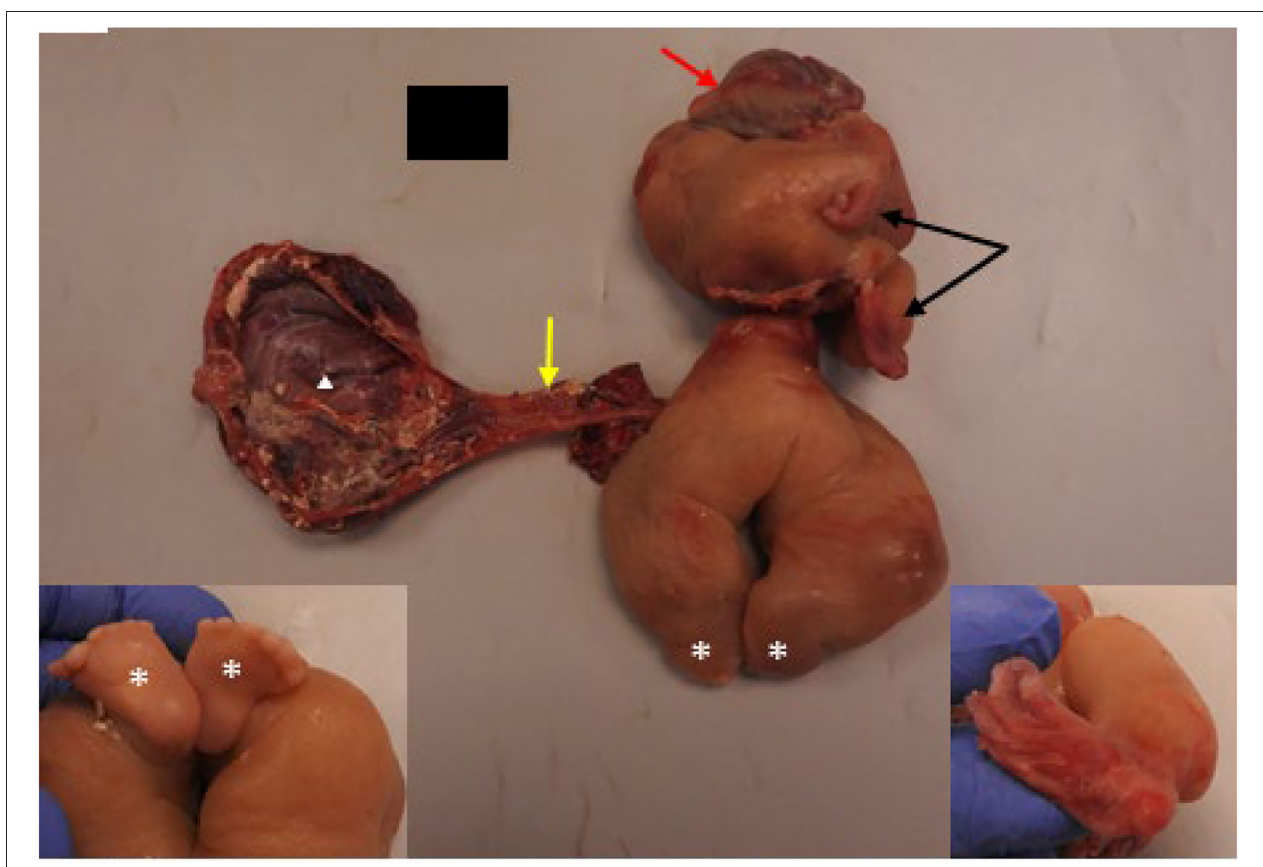
FIGURE 4 | Pathologic features of resected FIF with gross examination showed a malformed fetus with rudimentary upper (black arrows) and lower (white asterisks) extremities. Brain covered by dura (red arrow) was present; cranial bones were absent. A possible rudimentary umbilical cord (yellow arrow) was seen connecting the abdomen of the FIF to a sac-like membranous structure (white triangle). Left inset shows two feet connected to rudimentary legs opposite to the site of asterisks. Note both feet contains six toes. Right inset shows rudimentary, presumed left hand which is deviated and contained four digits. The other hand (no inset) had two